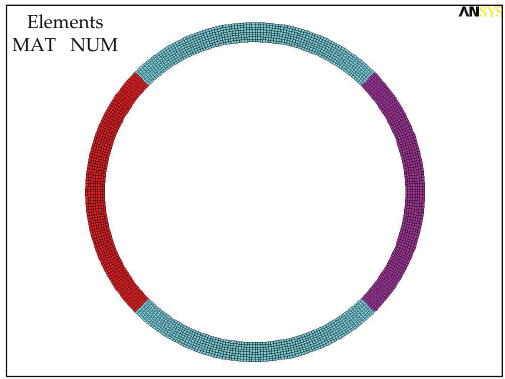
Figure 9: FE modelling of a inhomogeneous